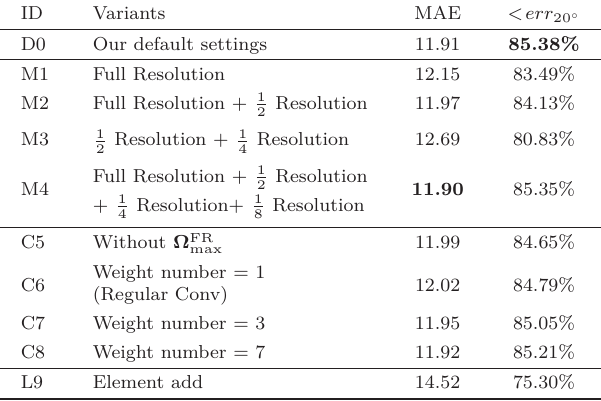
Table 1 MAE and < err 20 ◦ errors using different components of CHR-PSN on the validation set (with 32 input